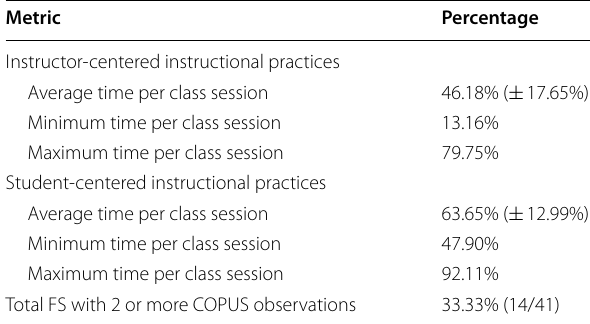
Table 3 Faculty Scholar percent time on instructor- and student-centered instructional practices, per class session